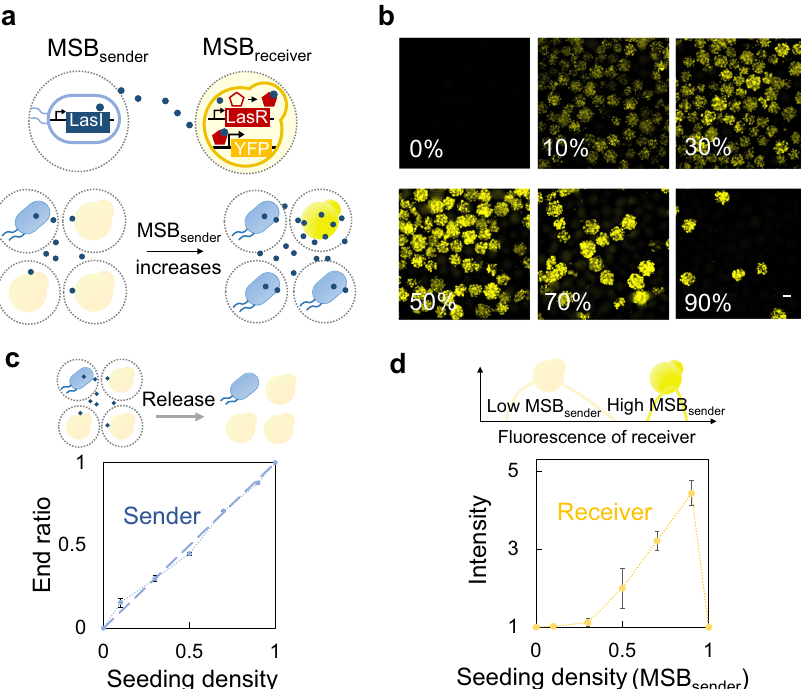
Fig. 6 MSBC platform enabled communication across the species. a Schematic shows that MSBC platform could modulate the communication across the species. We programmed the E. coli to express 3-oxo-C 12 -HSL (3OC12) under induction and generated the MSB sender . We programed the S. cerevisiae with a circuit bearing the corresponding inducible allosteric transcription factors (VP16-LasR), and generated the MSB receiver . The signals (3OC12) of MSB sender diffused across the cell membranes and polymeric capsules, and were sensed by the MSB receiver to drive the expression of the YFP. MSBC could tightly module the signal intensity. A higher MSB sender seeding density led to an increased concentration of signaling molecules, which triggered a stronger expression of YFP of MSB receiver . b Increasing the seeding density of MSB sender gradually lighted up the MSB receiver . MSB sender and MSB receiver were co- cultured with different seeding ratios (~2000 MSBs in total) into the medium (1 mL LB + SC). The number on the images indicated the seeding density